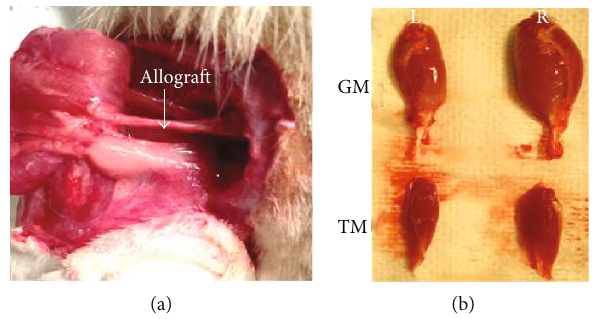
Figure 2: An allograft with AFS cell implant at the end of 4 months postinjury. (b) Isolated gastrocnemius (GM) and tibialis muscles (TM) from the experimental (L) and contralateral control side (R).